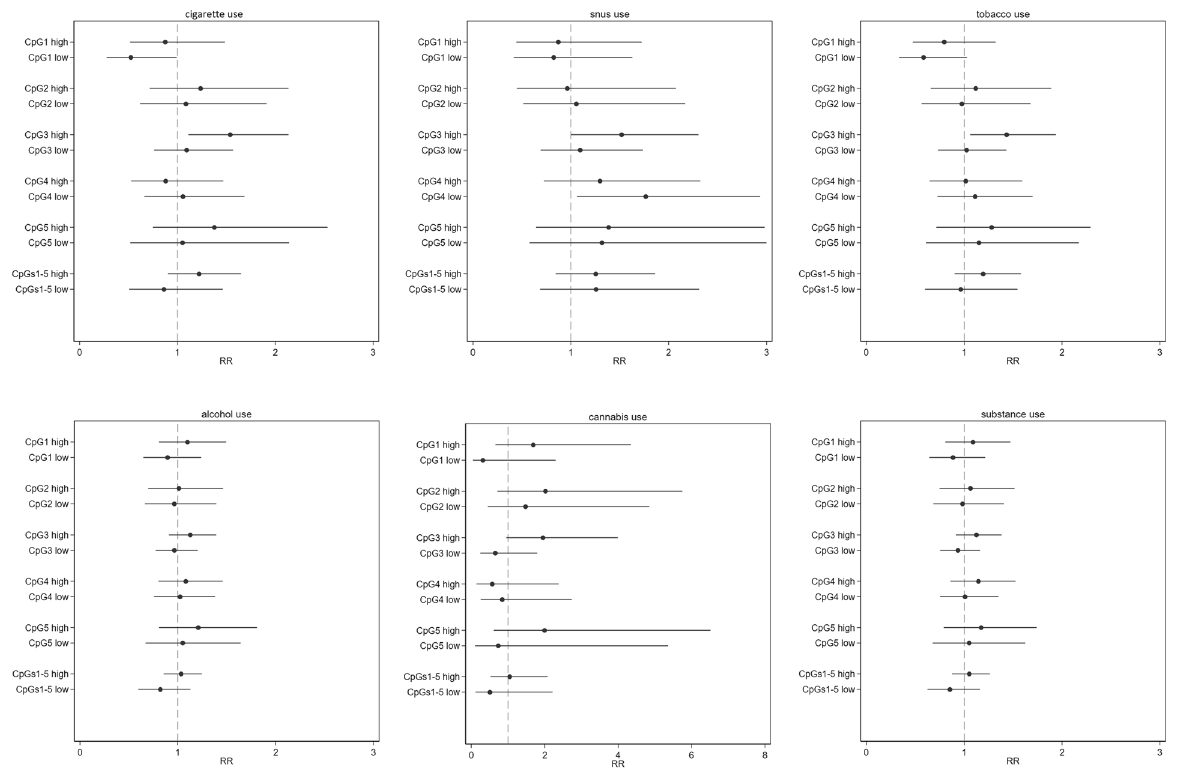
Fig. 3 Bi-variate association between NR3C1 methylation at baseline and lifetime substance use assessed over 3 years in adolescent participants of the KUPOL study. The results should be interpreted in terms of rate ratios (RRs) with 1 as a null value. Methylation level 0% was considered as the reference category. Low methylation group: methylation levels below the median of detectable methylation and high methylation group: methylation levels above the